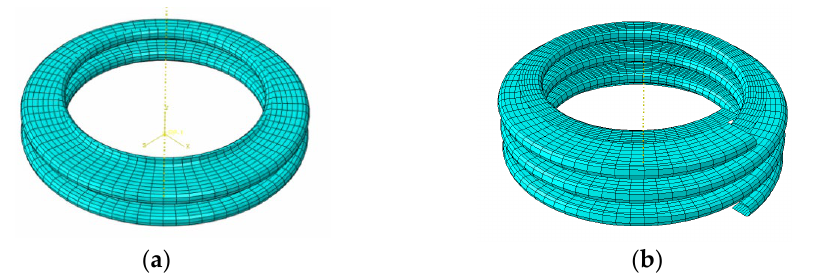
Figure 4. FE models of the two types of U-shaped bellows; ( a ) toroid bellows and ( b ) spiral bel- lows.